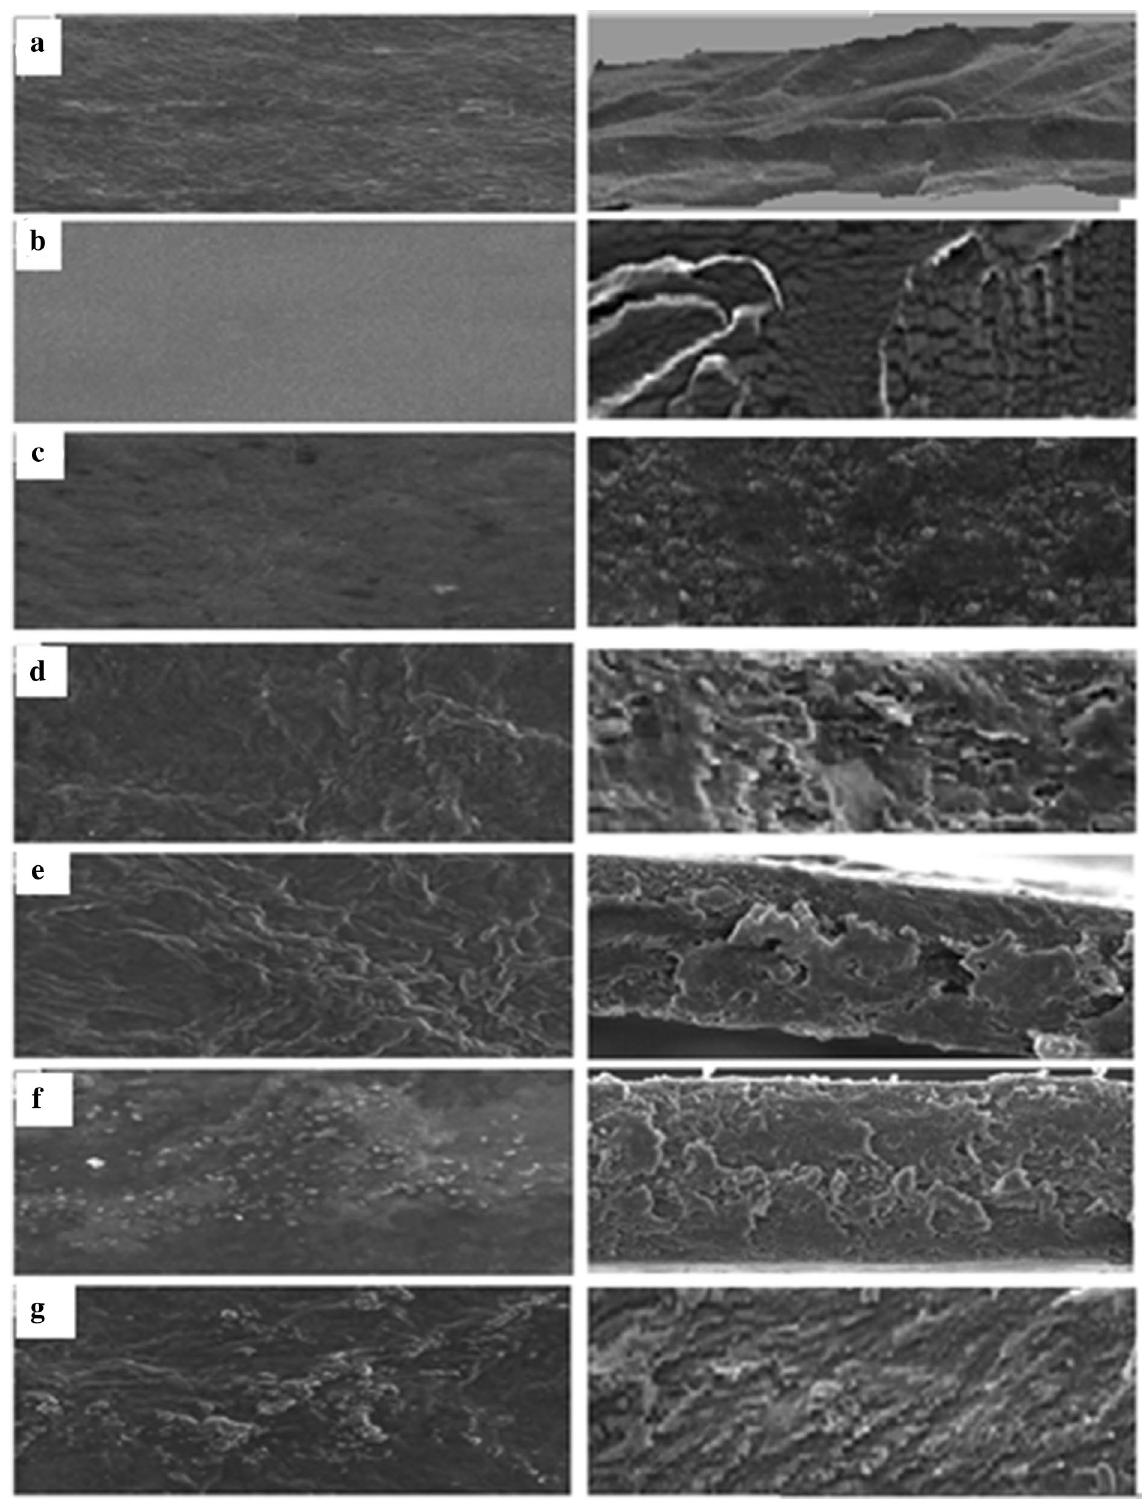
Figure 6. SEM images of surface morphology (right) and their corresponding cross-sectional (left) of ( a ) BC, ( b ) SA, ( c ) BC/SA, ( d ) BC/SA/GM1, ( e ) BC/SA/GM2, ( f ) BC/SA/GM3, and ( g )